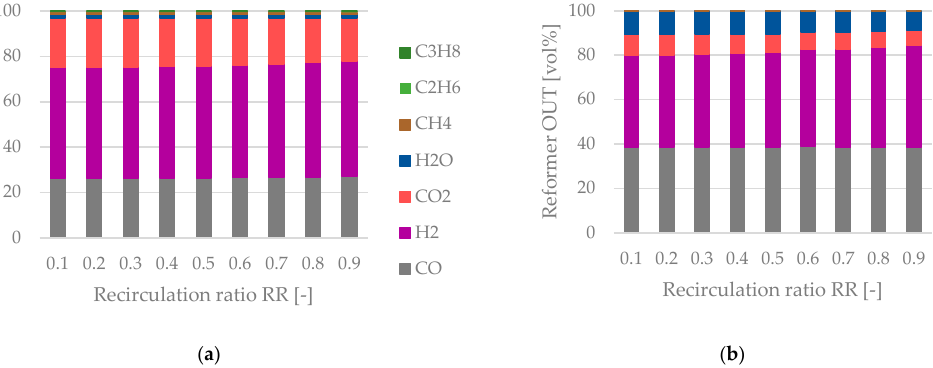
Figure 11. Tail gas reforming—( a ) tail gas composition at the reformer’s inlet, ( b ) tail gas composition at the reformer’s outlet as a function of the recirculation ratio.